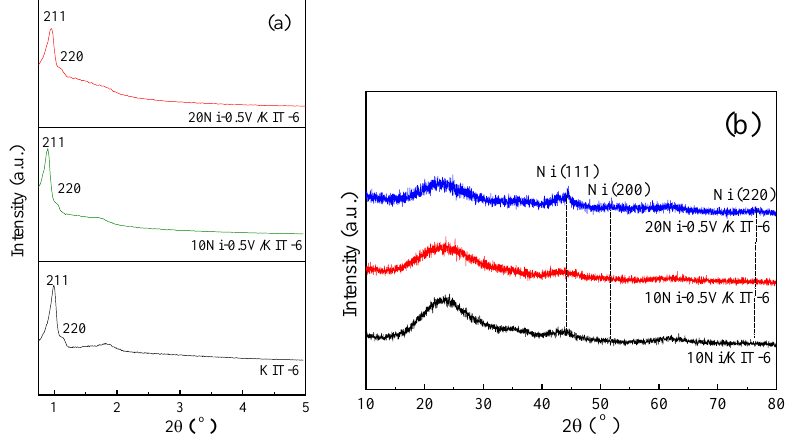
Figure 1. ( a ) Low-angle XRD patterns of support and catalysts; ( b ) Wide-angle XRD patterns of Ni-based catalysts. Table 1. Physicochemical properties of Ni-based catalysts.